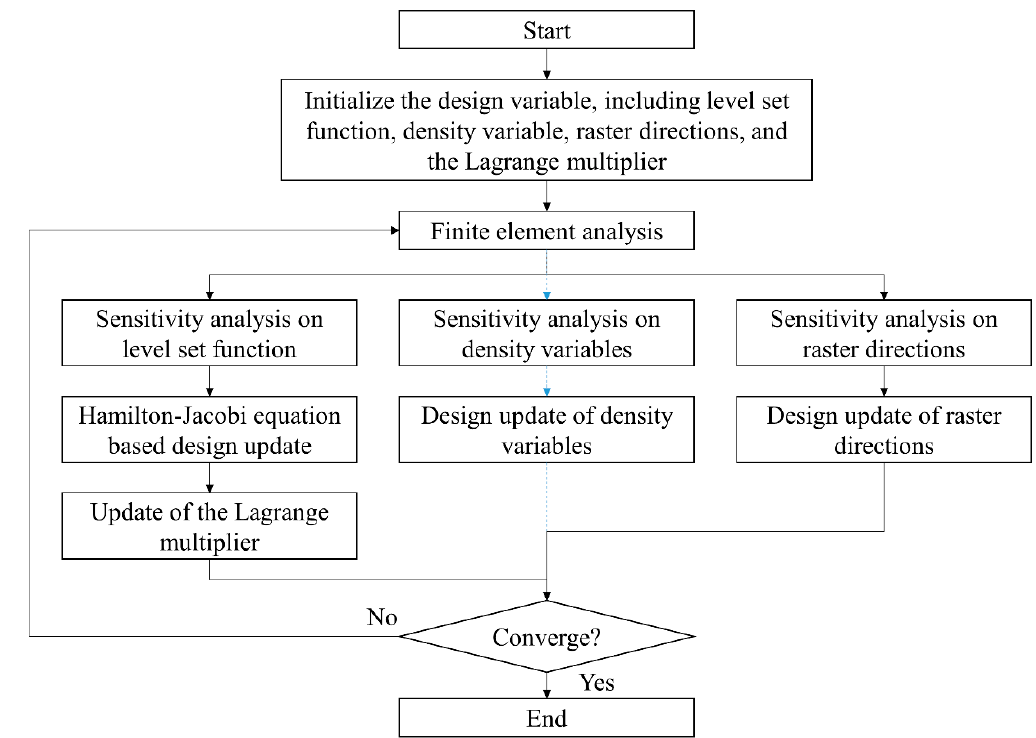
Figure 3. Flow chart of the solution process.